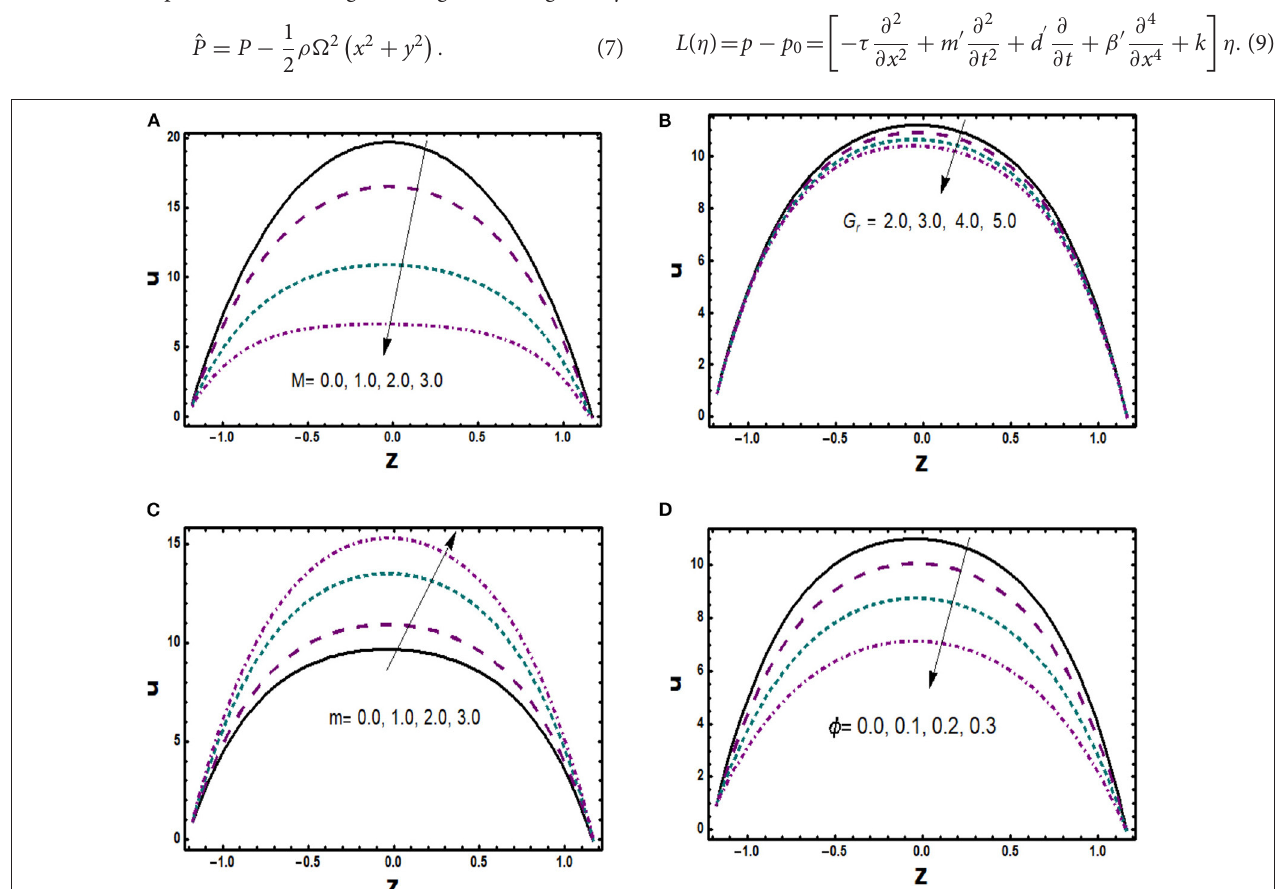
FIGURE 2 | (A–D) Effects of M, Gr, m, and φ on u ( z ).